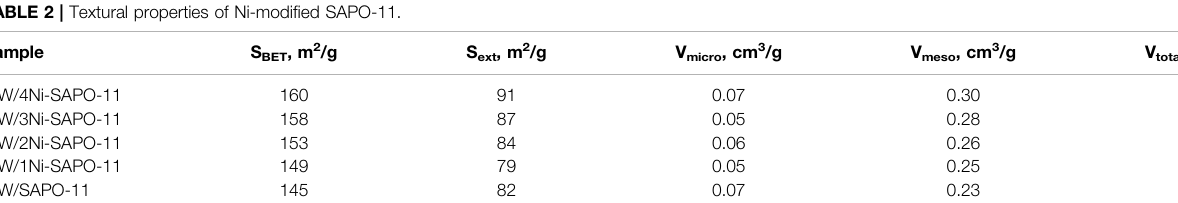
TABLE 2 | Textural properties of Ni-modi fi ed SAPO-11. Sample S BET , m 2 /g S ext , m 2 /g